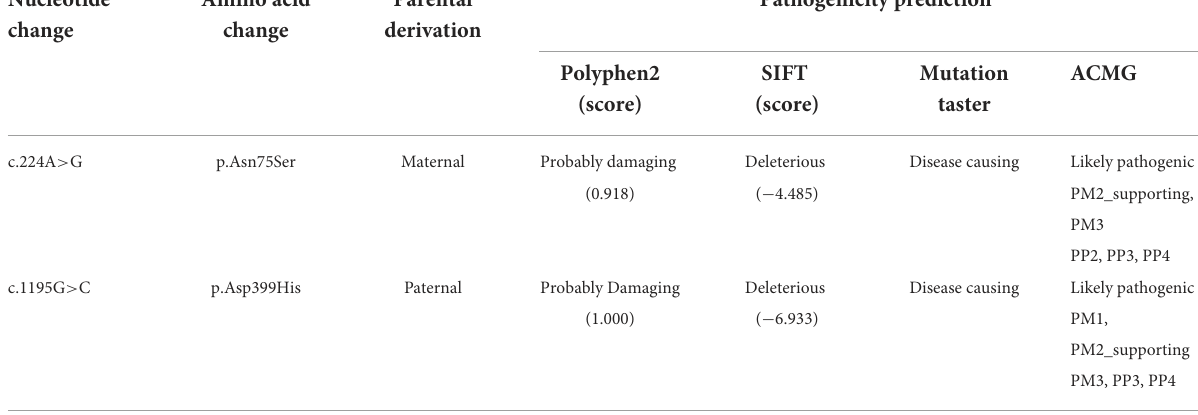
TABLE 1 The pathogenicity predicted using online tools.